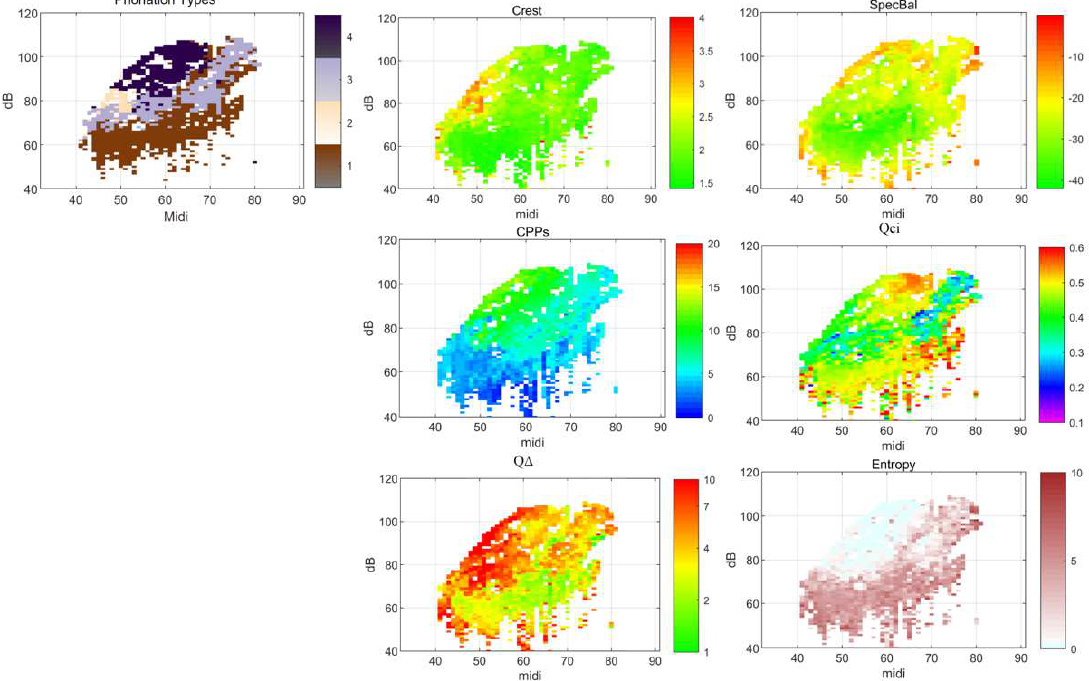
Figure 7. Voice map layers of the phonation types and the underlying metrics, from a male speaker, M06, when k = 4. Clockwise from top left: four phonation type clusters, the Crest factor, the spectrum balance (SB), the cepstral peak prominence smoothed (CPPs), the EGG cycle-rate sample entropy (CSE), the normalized peak dEGG ( Q ∆ ), and the EGG quotient of contact by integration ( Q ci ). The x -axis is f o in semitones (on the MIDI scale, 48 = 110 Hz), and the y -axis is SPL in dB(C) at 0.3 m. Are all these metrics needed? To address this question, the classification was per- formed with EGG only (three metrics), acoustic only (three metrics), and EGG + acoustic The Crest factor contributes the most to the cluster corresponding to the speech range on the left of this voice map, colored by the pale yellow in the phonation type layer (and the redder region on the left of the Crest factor layer). At the same time, in EGG metrics, the Q ci and Q ∆ seemingly imply the tendency from the lower left to the upper right. The CPPs tured voice map. and CSE as stability indicators for voice signal and EGG signal each independently expose the lower breathy and soft regions. Though the CPPs and CSE show similar impacts on distinguishing the loud and soft regions, a slightly different portrait in the transitional region affects the boundaries of the loud and the transition